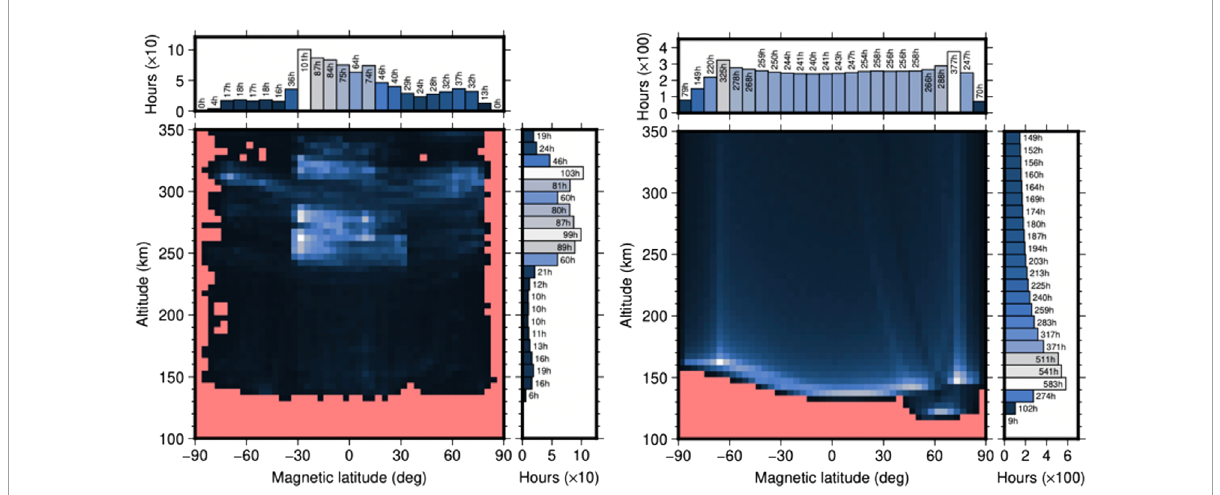
FIGURE 5 Left: Total observation time from AE-C, AE-D and AE-E combined, as a function of altitude and magnetic latitude. Total observation time at altitudes below 200 km is 60.3 h (Unified Abstract data). Right: Targeted total observation time from a 3-year in situ mission dedicated to studying LTI processes: ∼ 2000 h at altitudes < 200 km. Deep-dips (perigee descents) according to this concept are performed down to 120 km when perigee is over high latitudes. [Figure by E. Doornbos; adapted from Sarris et al.